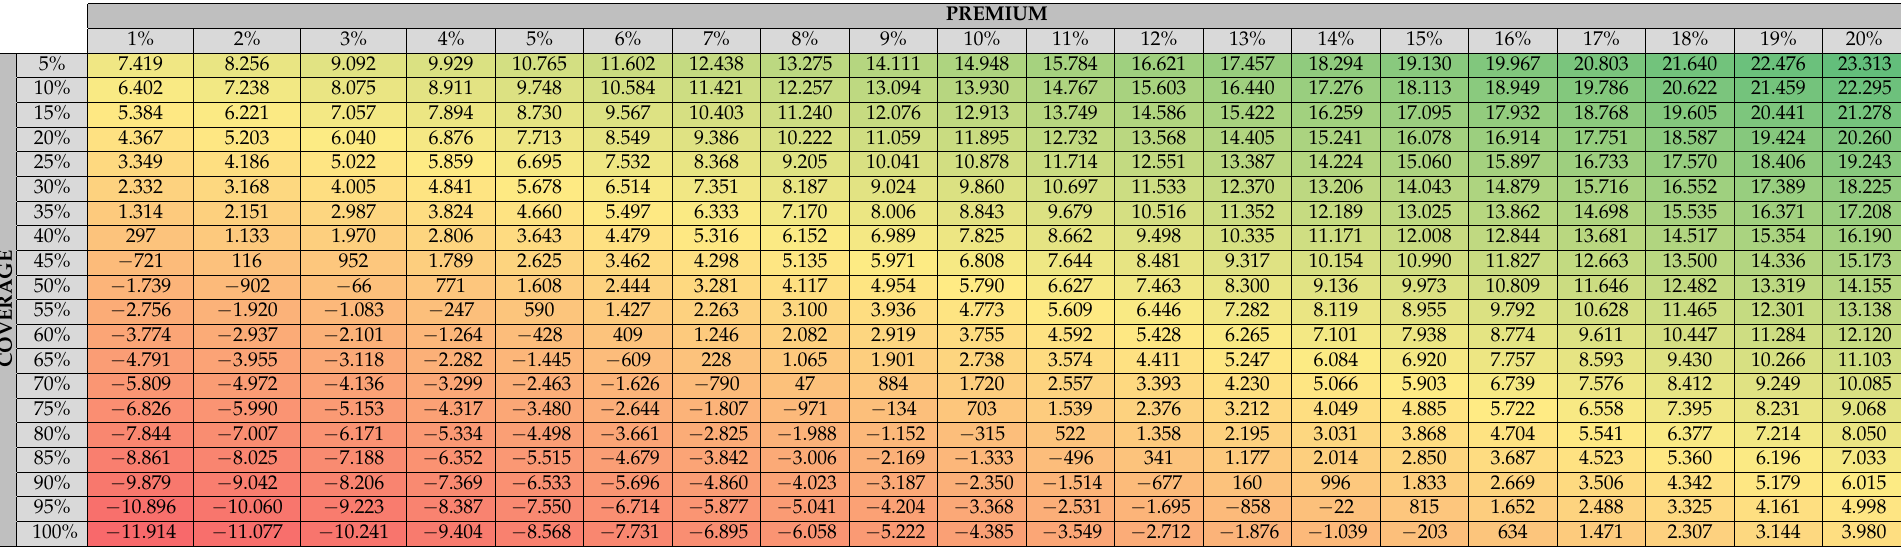
Table 4. Total assets balance after 10 years of operation of a EUR 10 million risk insurance scheme (in thousands of EUR): sensitivity analysis between risk coverage and insurance premium; Scenario B drilling exploration success